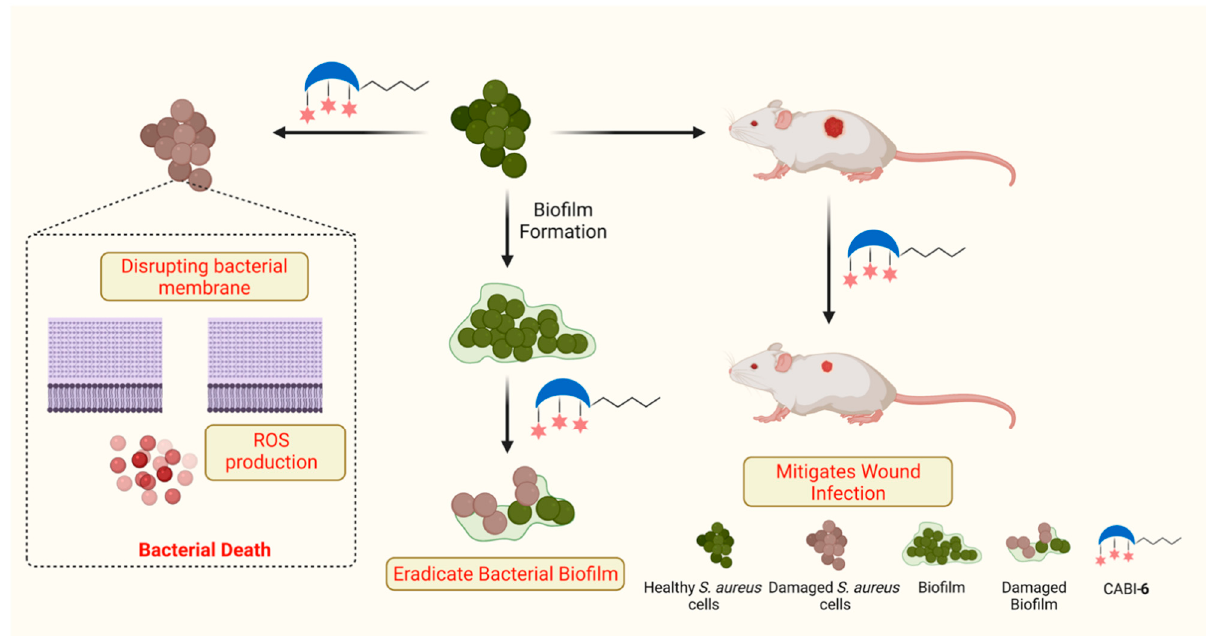
Figure 1. Schema illustrating the antibacterial activities of synthesized amphiphile.